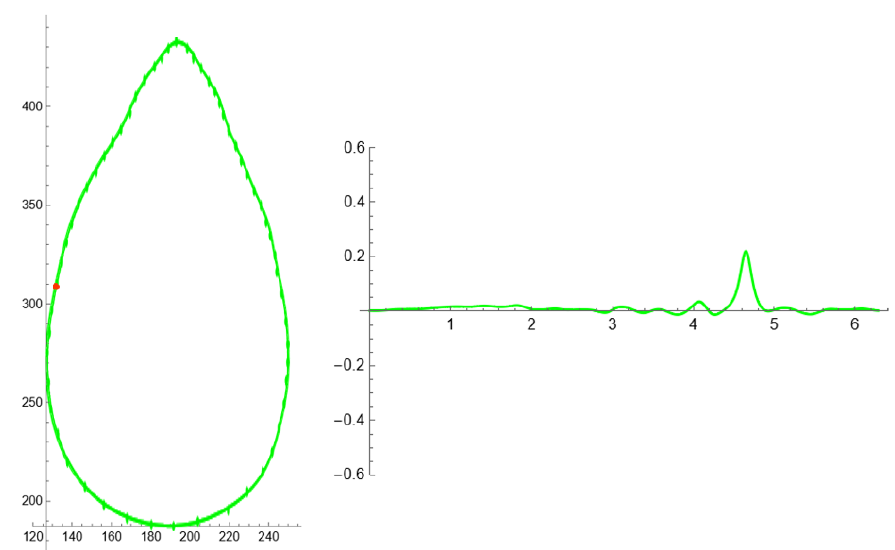
Figure 4. ( Left ) The silhouette of the seed image of A. natalia given in Figure 1 with points marked on it. The series of points start in the red point marked and go counter-clockwise. ( Right ) curvature values corresponding to the points along the silhouette.